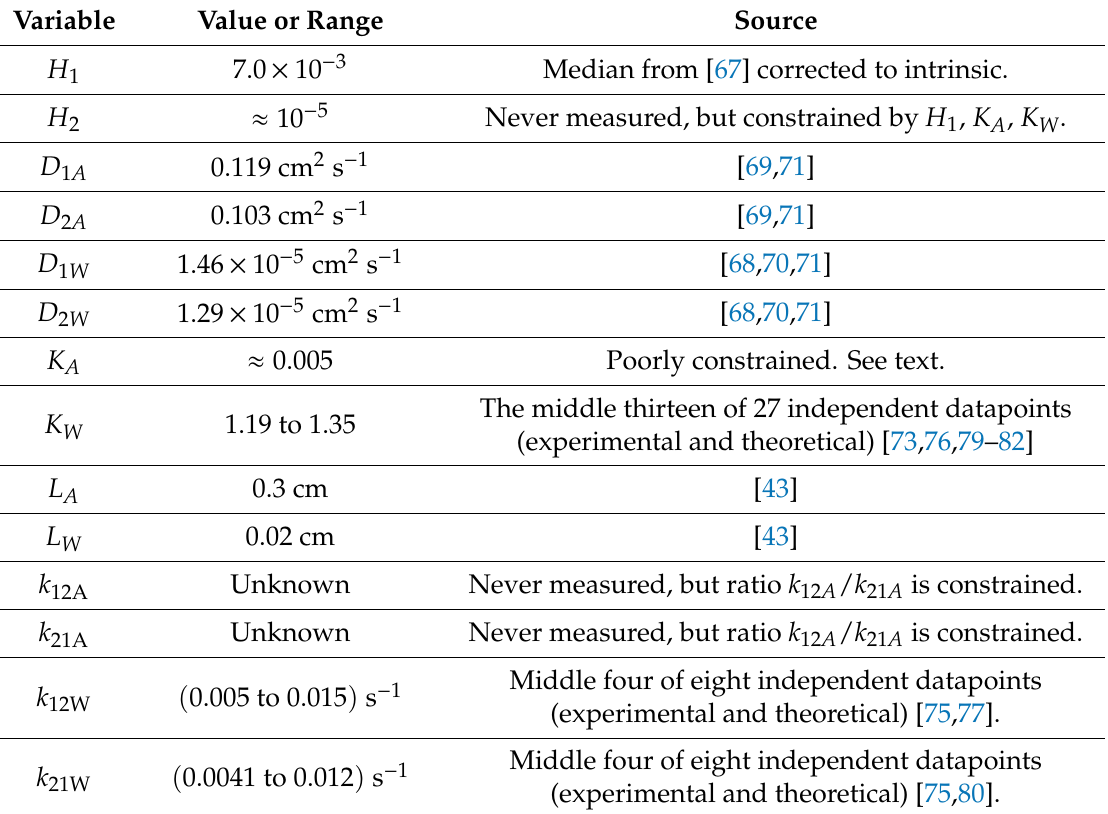
reaction at ≈ 300 K and pH 2